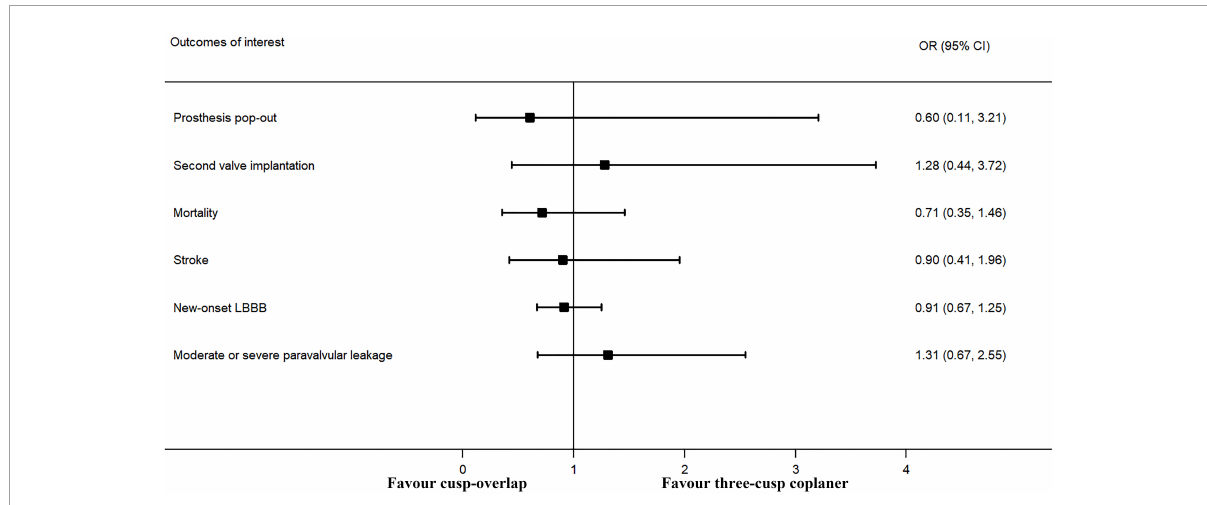
FIGURE4 Meta-analysis of secondary outcomes of interest (categorical variables). LBBB, left bundle branch block. Forrest plot has shown the comparison of secondary outcomes of interest, including prosthesis pop-out, second valve implantation, post-operative mortality, post-operative stroke, post-operative new-onset LBBB, and moderate or more paravalvular leakage after TAVR procedure. The heterogeneity was not significant in any of the analyses, and a fixed-effects model was used. The bars represented a 95% CI.